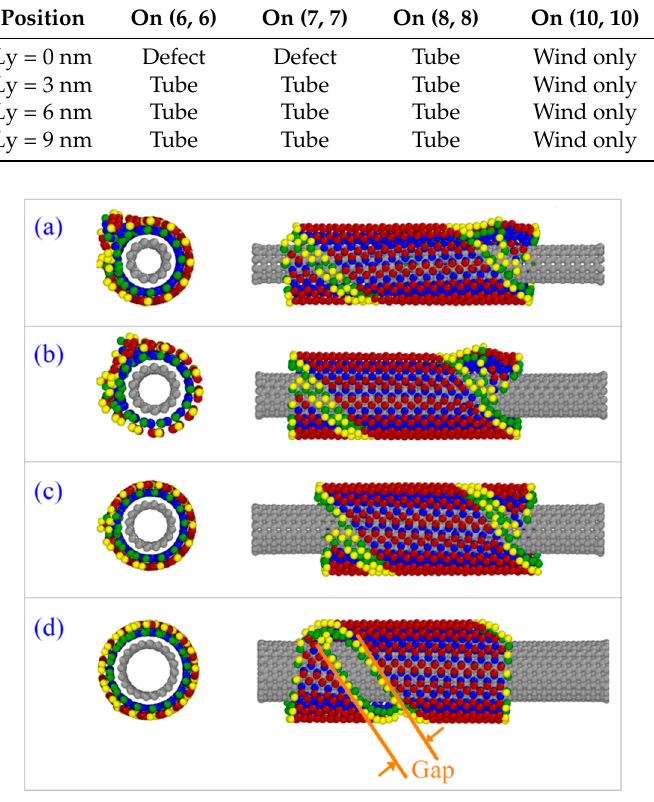
Figure 1. Snapshots of the system at 500 ps when α = 0°, L y = 0 at 14 K. ( a ) On CNT (6, 6). ( b ) On CNT (7, 7). ( c ) On CNT (8, 8). ( d ) On CNT (10, 10). Table 1. Final states of the BP with 4 types of CNTs at different initial positions along the y-direction with α = 0° at 14 K. “Tube” means the BP ribbon forms into an ideal tube. “Defect” means the BP nanotube has a defect. “Wind only” represents the ribbon just winds upon the CNT, but does not form into a tube.